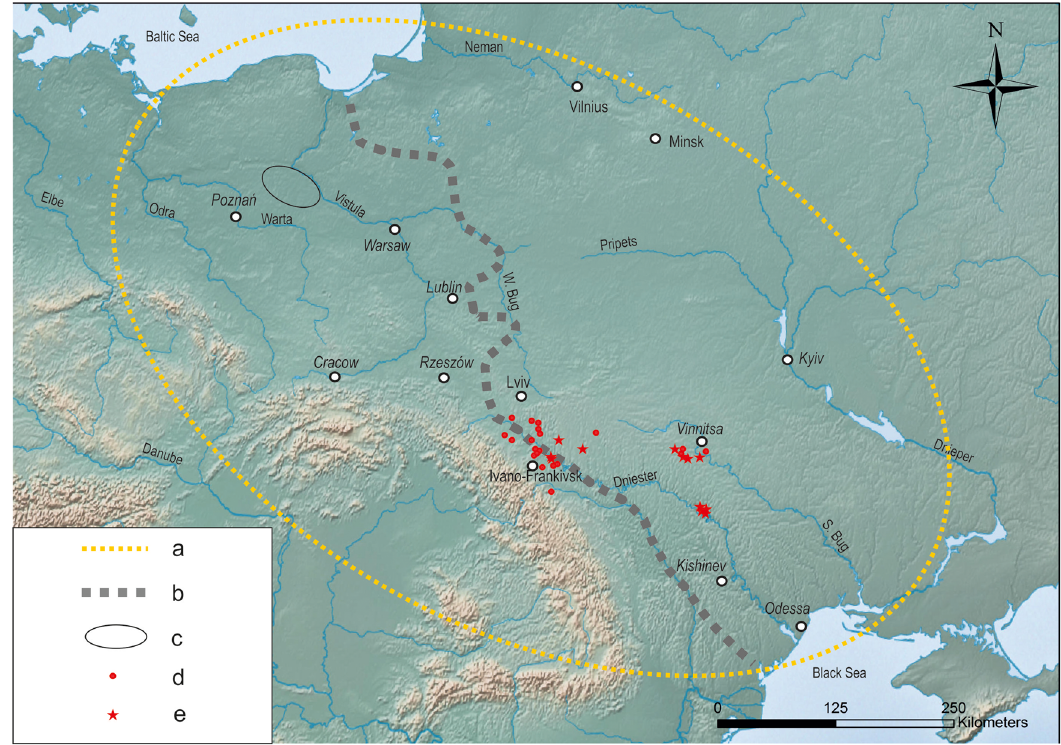
Figure 1: Intermarine Area and sites investigated by archaeologists of Adam Mickiewicz University in Pozna ń in cooperation with National Academy of Sciences of Ukraine, Institute of Archaeology. ( a ) Intermarine Area; ( b ) natural boundary of Eastern and Western Europe ( Bug - Dniester “ limes ” ) ; ( c ) Kuyavia region; ( d ) sites investigated only with non - invasive methods; and ( e ) excavated